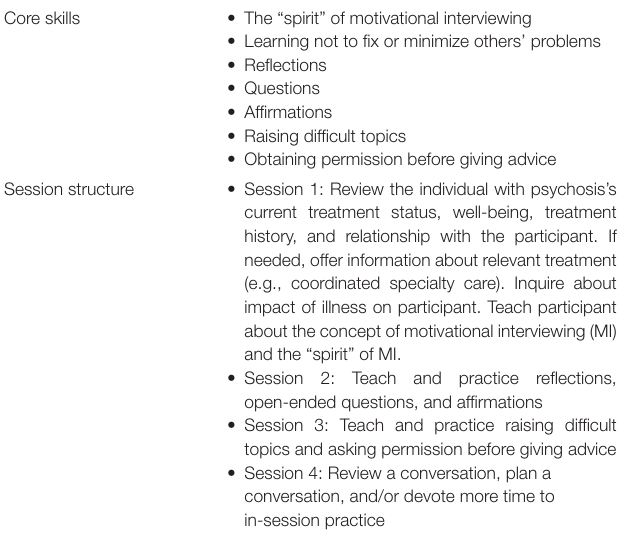
TABLE 1 | Motivational interviewing for loved ones: session content. Core